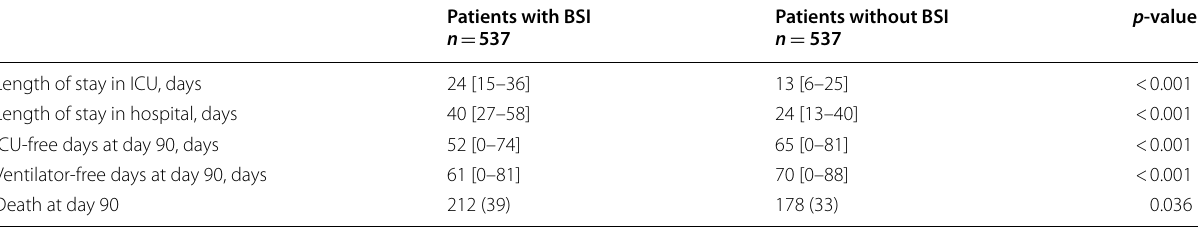
Table 4 Outcomes among 537 patients with bloodstream infection and their 537 propensity‑matched patients without bloodstream infection